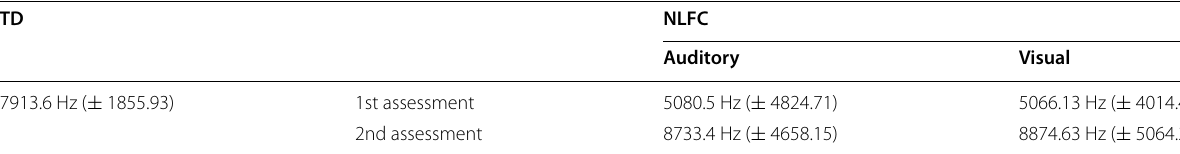
Table 4 Mean of F2 onset in /fi/ syllable in TD and NLFC groups